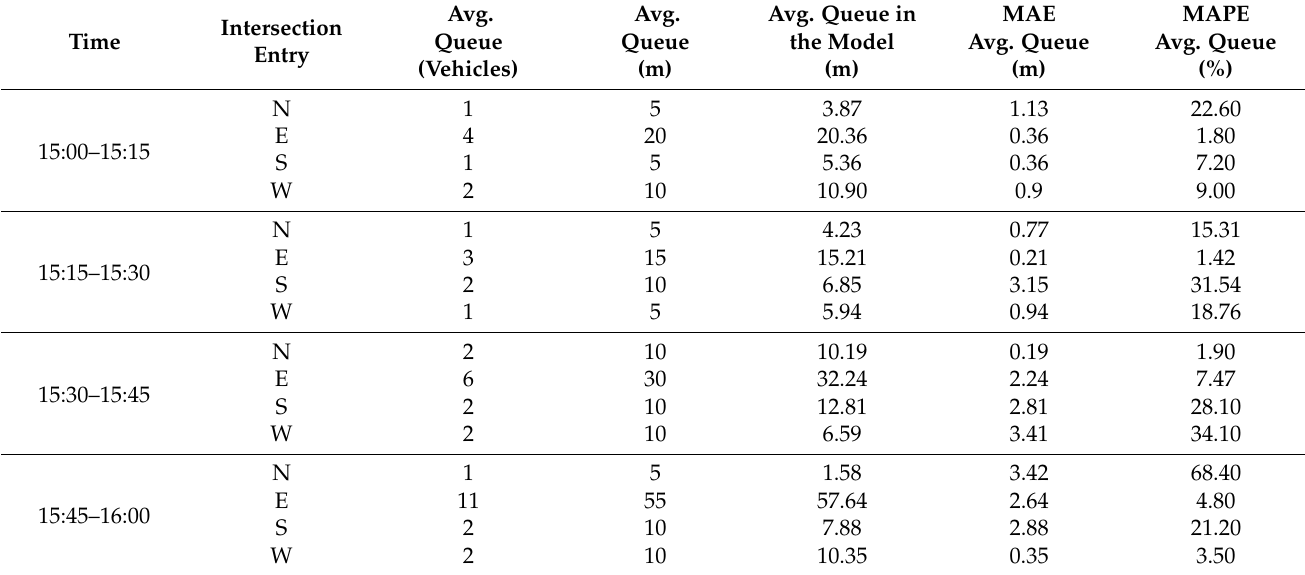
Table 2. Comparison of observed queue length with modeled